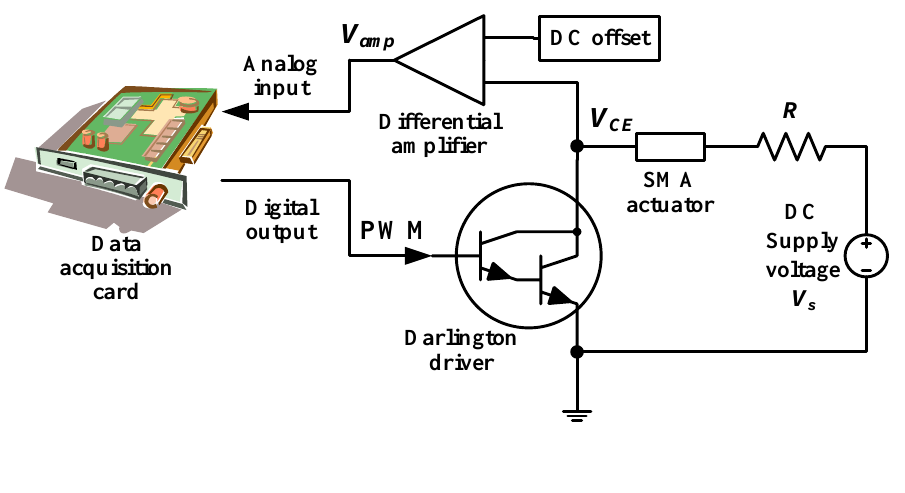
Figure 2. Schematic of the electric